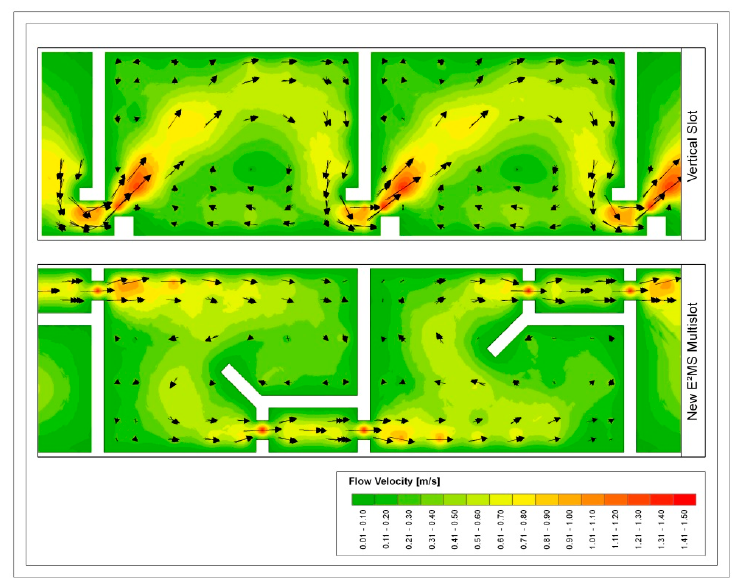
Figure 11. Uniform flow pattern (measured in the hydraulic lab of University of Natural Resources and Life Sciences, Vienna, Austria (BOKU) in the enature ® fish pass caused by a significant reduction of the turbulent kinetic energy and the fish pass flow [22]. Comparison with flow pattern in a standard vertical slot fish pass.